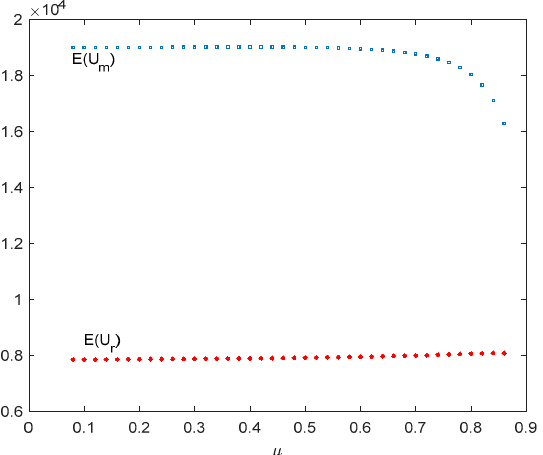
A and A with respect to μ with different r m